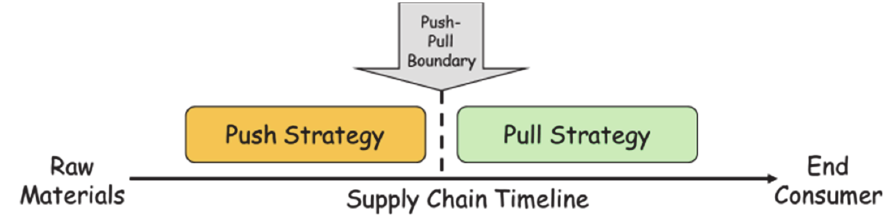
Fig. 1. Order Penetration Point as tactical and strategic link among